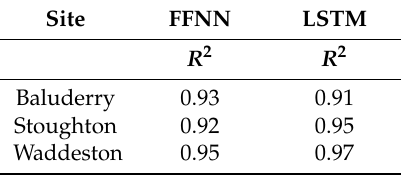
Table 5. Training cross-validation performance of two-layer neural network